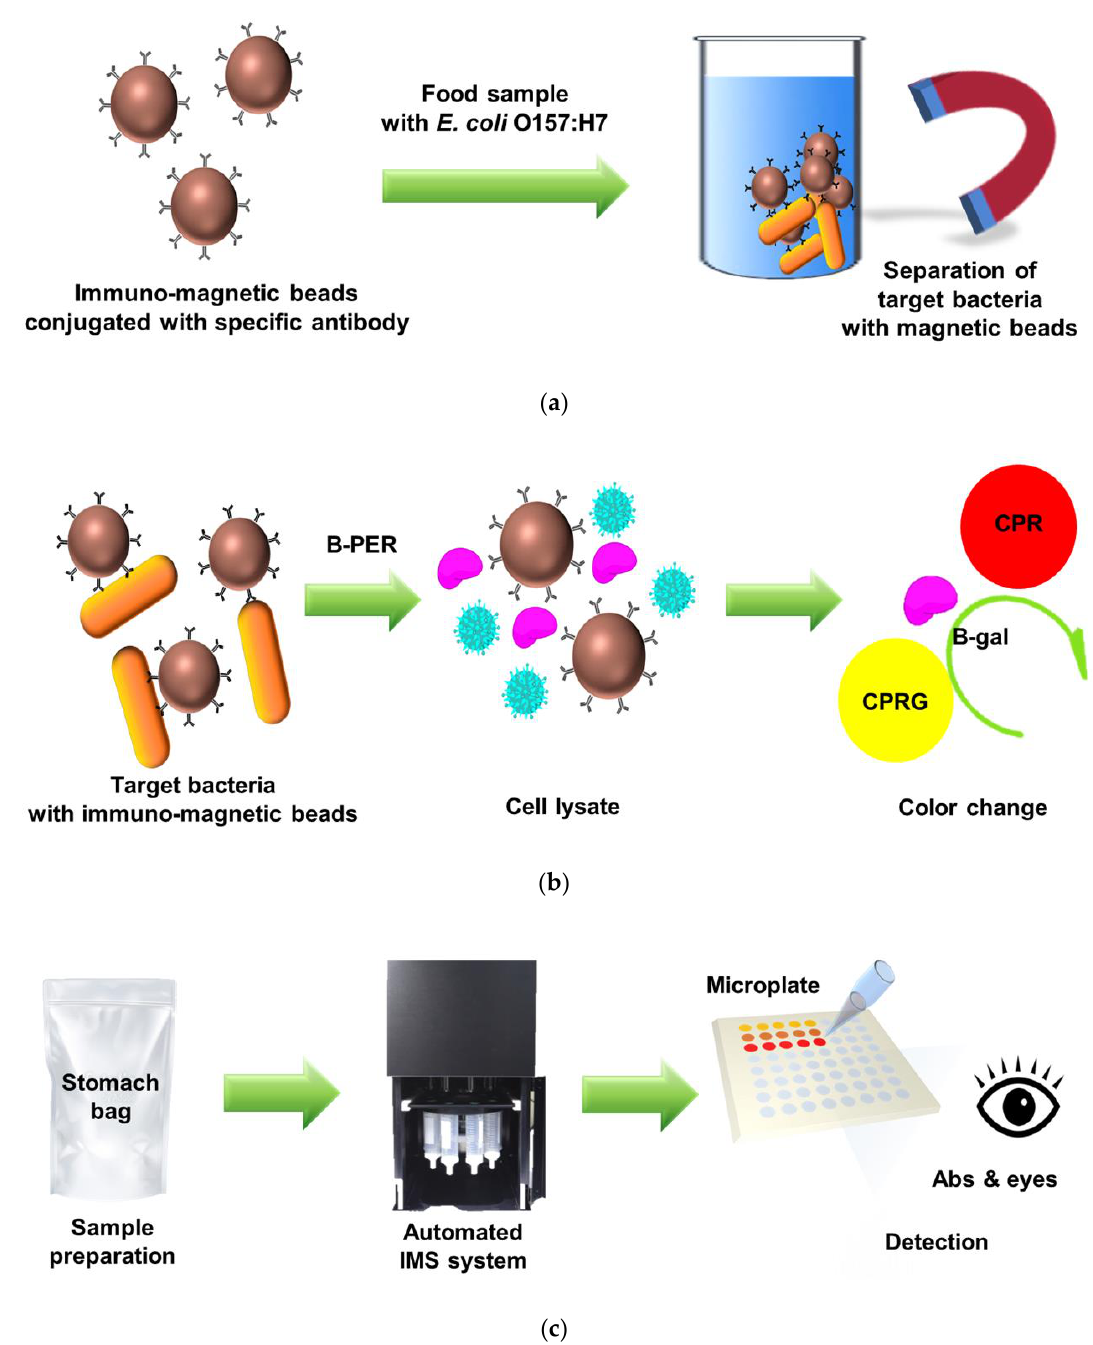
Figure 1. Schematic illustration of experimental procedures: ( a ) The basic principle of the Immunomagnetic separation (IMS) method for separating and concentrating target bacteria from a sample; ( b ) Colorimetric response of β -GAL enzyme-base converting chlorophenol red β -galactopyranoside (CPRG) into CPR after lysis of the target bacteria using a B-PER; ( c ) Proposed detection approach using automated IMS system combined with colorimetric reaction assay. This system is able to detect target E. coli O157:H7 via absorbance measuring or the naked eye.